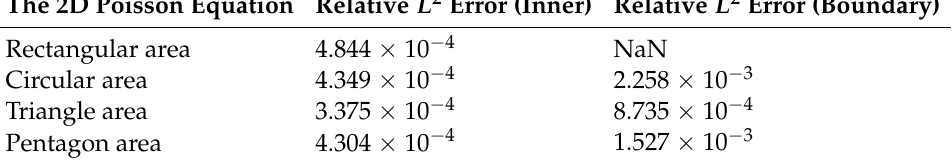
Table 1. The 2D Poisson equation: Relative L 2 errors obtained by cSPINN on different geometries. ( Ω 1 = [ 0,0.25 ] × [ 0,0.25 ] ). The 2D Poisson Equation Relative L 2 Error (Inner) Relative L 2 Error